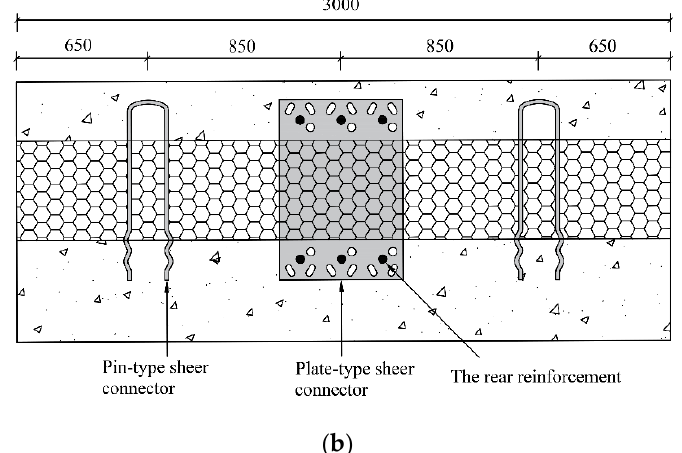
Figure 4. ( a ) General arrangement of stainless steel connectors; ( b ) Detailed drawing of stainless steel shear connector. Table 1. Basic parameters of the specimen.